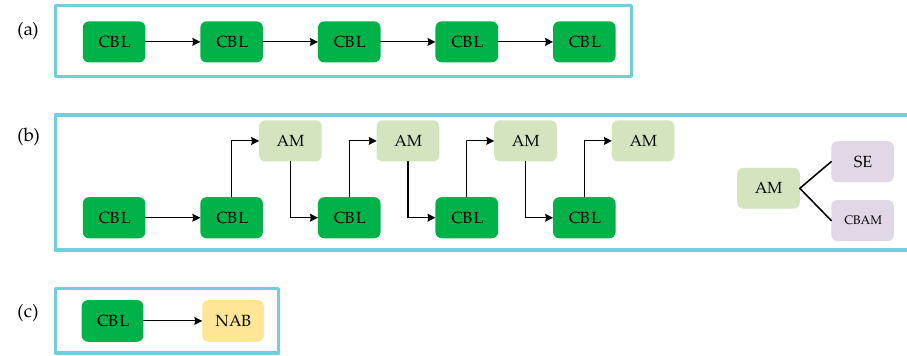
Figure 8. ( a ) The original ‘CBL5’in the neck. ( b ) The improved ‘CBL5’with the attention mechanism in the neck. ( c ) NAB in the neck. The structure of ‘CBL’ is shown in Figure 4. ‘AM’, which is the abbreviation of attention mechanism, could be SE or CBAM.